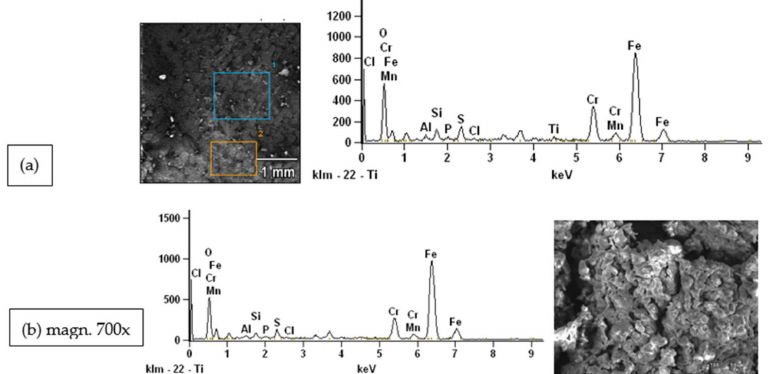
Figure 19. ( a ) Chemical composition of the surface of heat-resistant steel H25T in planes pt1 and pt2; ( b ) microscopic photo (SEM) of the surface of H25T heat-resistant steel.